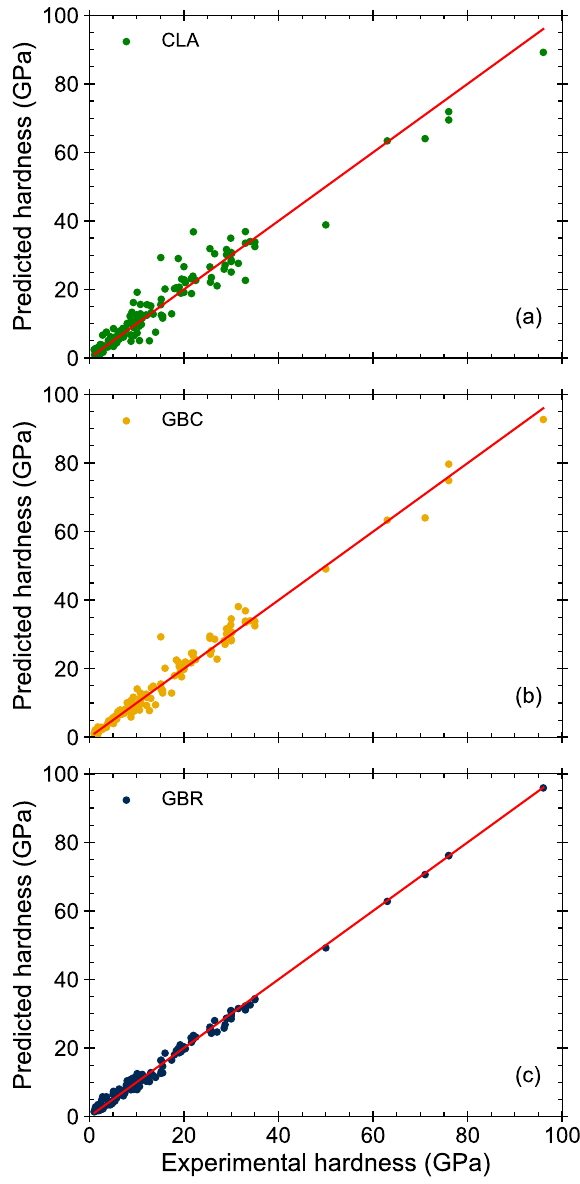
Figure 2. Comparison of the experimental Vickers hardness with the predicted values using: ( a ) The Classic Calculator as presented in Table 5 (CLA 1 ), ( b ) The Machine Learning Calculator using GBC and ( c ) GBR.